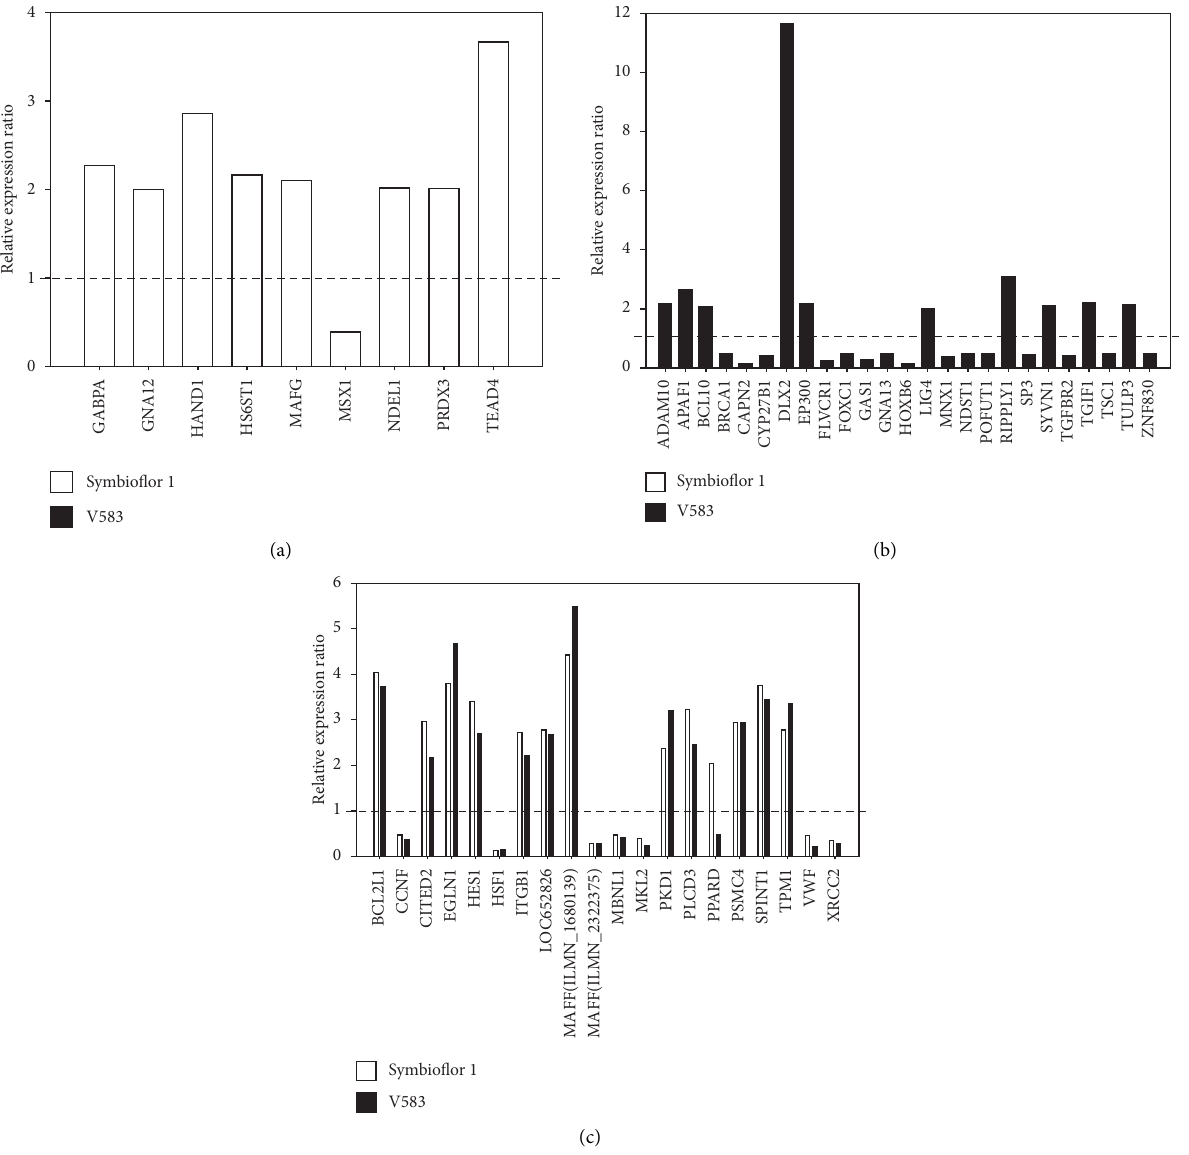
Figure 3: Fold change of DEGs classified into placenta and embryonic development. (a) Unique DEGs in the Symbioflor 1 treatment group; (b) unique DEGs in the V583 treatment group; (c) common DEGs in the Symbioflor 1 and V583 treatment groups. The relative expression ratio for each gene is presented in the histogram. A ratio greater than zero ( > 1) indicates upregulation of gene expression, and a ratio below zero ( < 1) indicates